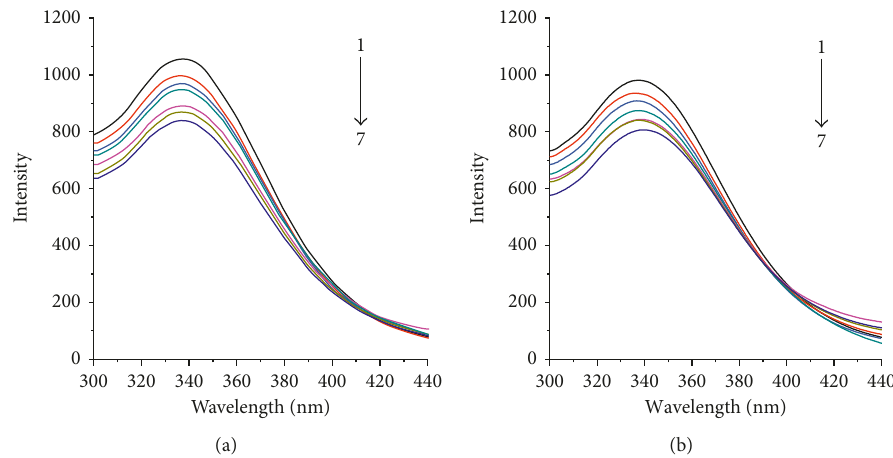
Figure 2: Fluorescence quenching spectra of protein hPPAR c with series concentrations of DBDF2,6Tat different temperatures: (a) 293K and (b) 310K.